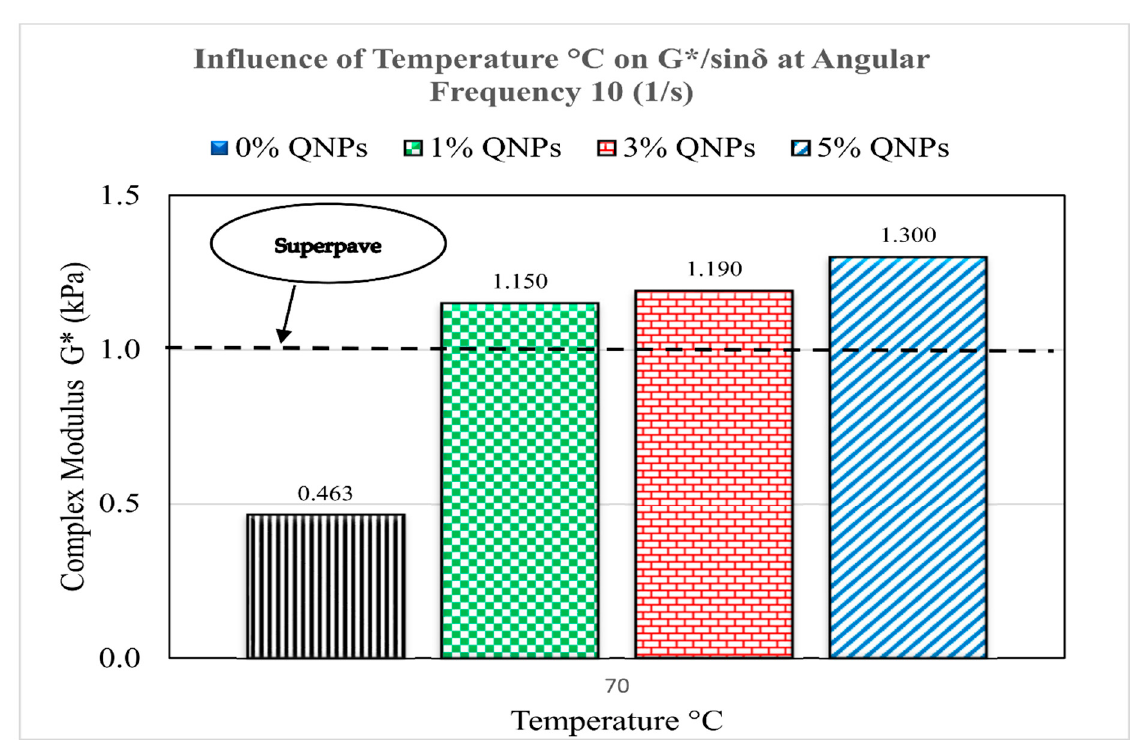
Figure 13. Graphical representation of the influence of temperature on G*.